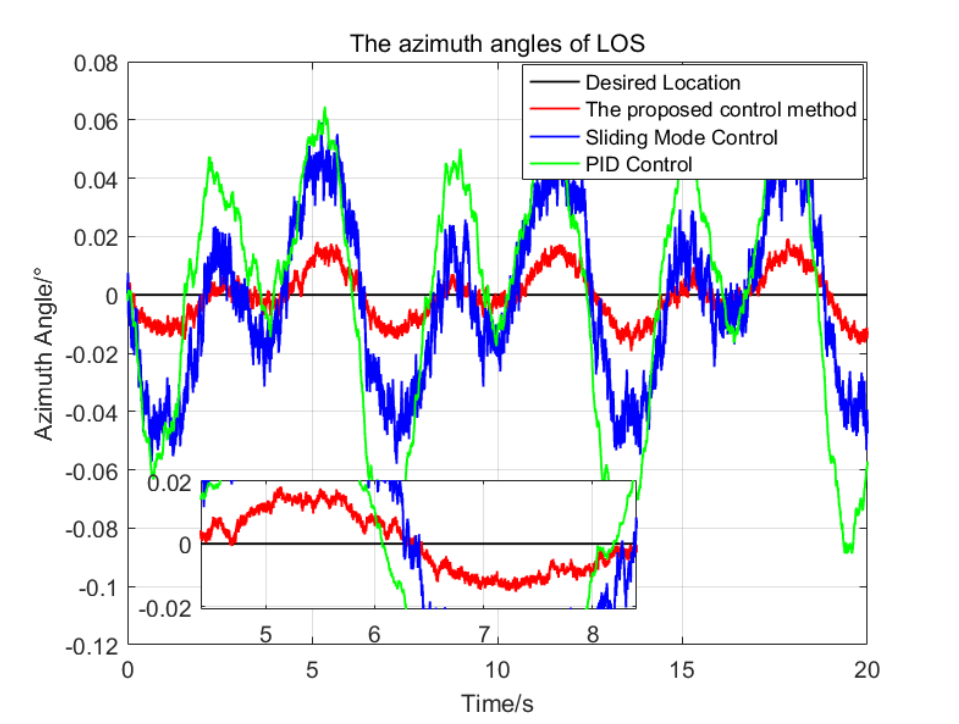
Figure 5. The comparison of the azimuth angles of the LOS generated by the three control methods. Table 2. The comparison of stabilization control performance of the three control